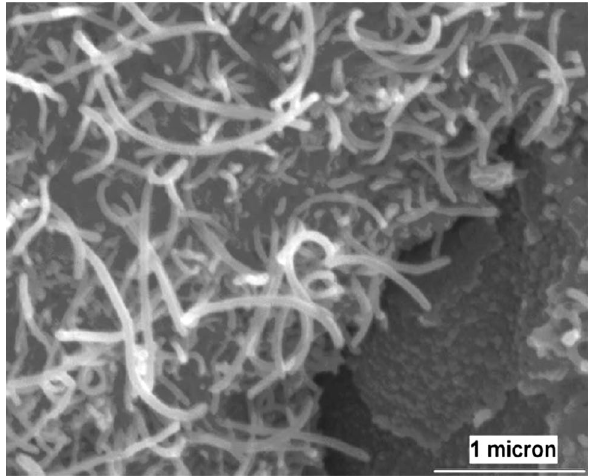
Fig. 13 SEM image of UHPCM reinforced with 0.03 wt.% CNF-OX, showing CNF pull-out